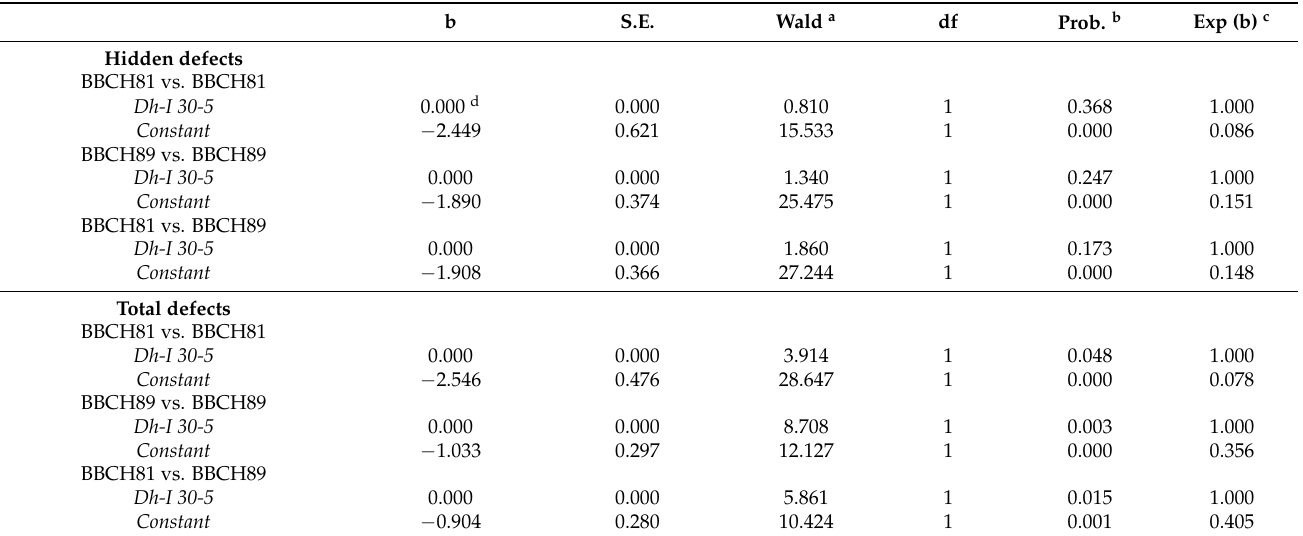
Table 2. Parameter b and statistics of logistic regression (Equation (1)) applied to predict probability of having hidden and total defective hazelnuts ( ≥ 1%) as function of output index of predictive model in different considered scenarios.